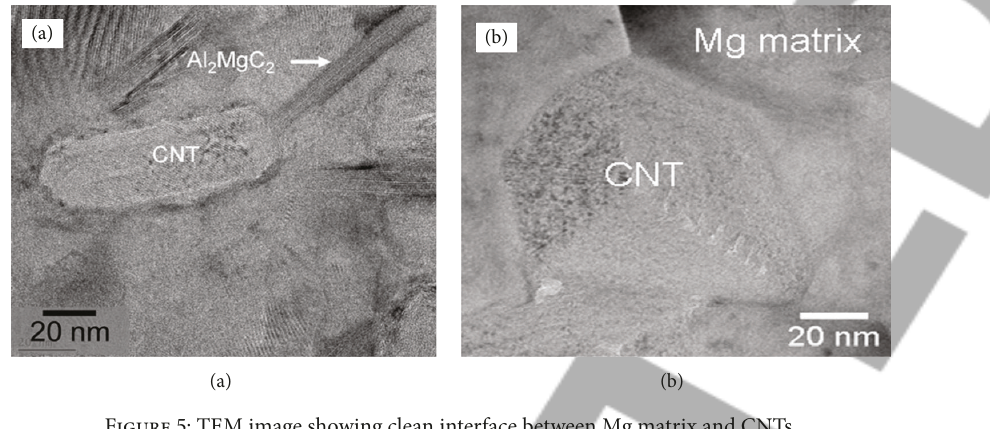
Figure 5: TEM image showing clean interface between Mg matrix and CNTs.